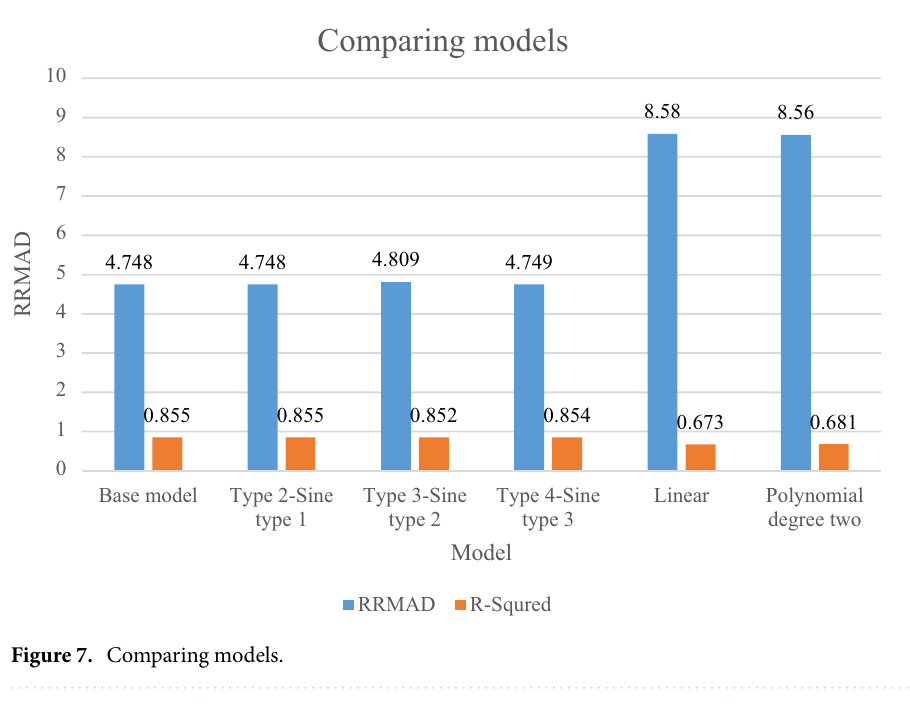
Figure 7. Comparing models.